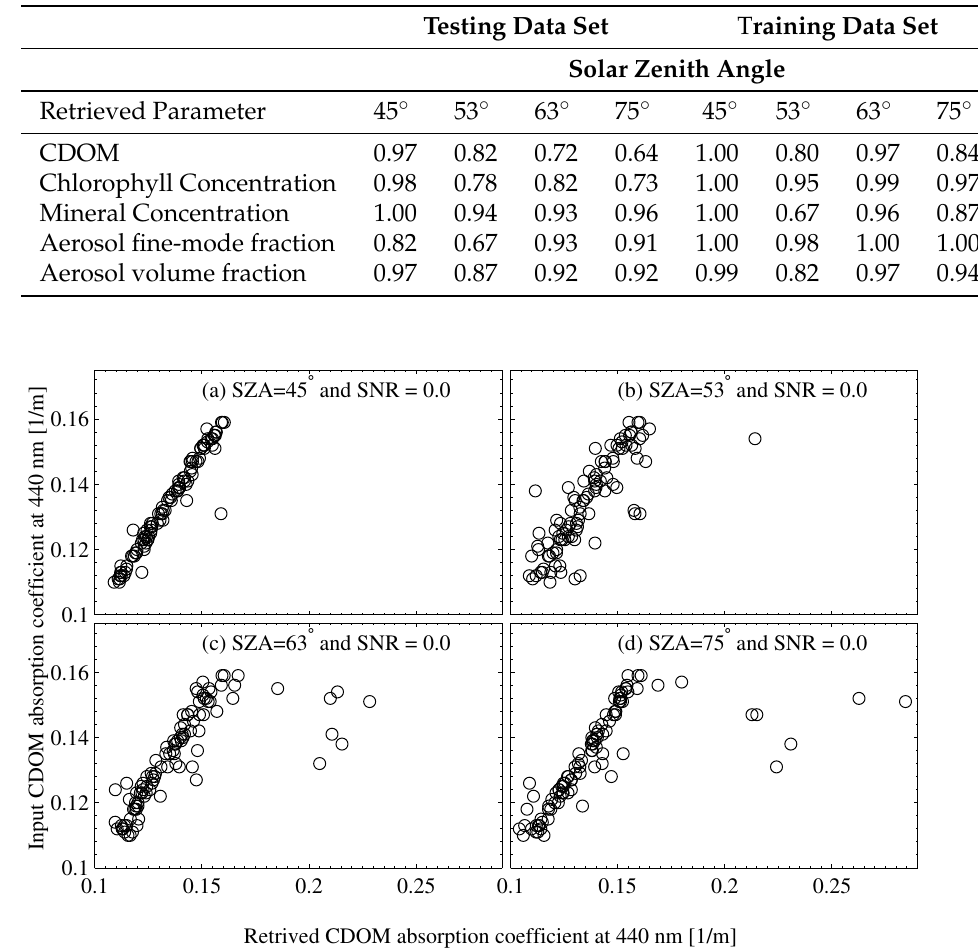
Figure 3. Comparison between input values and retrieved values for the CDOM absorption coefficient at 443 nm for different solar zenith angles